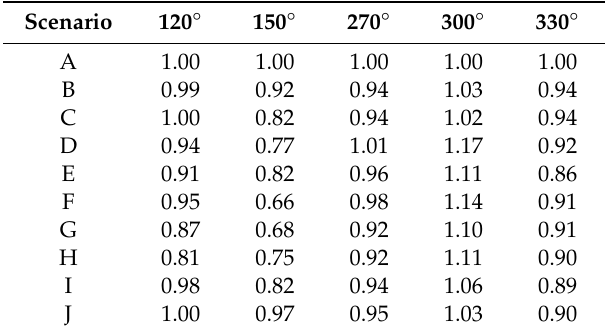
Table 2. Fraction of modeled wind speed at point WM 10 m (Figure 2) above the roof top for scenarios B to J to wind speed in scenario A (see text for explanation) under di ff erent upper level flow directions (at 100 m